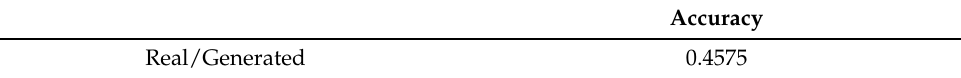
Table 2. The results of the classification between real and generated performed by experts. The accu- racy score is the mean of the participants’ performance.